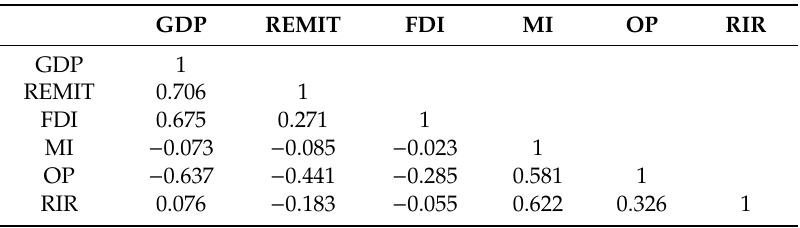
Table 2. Correlation